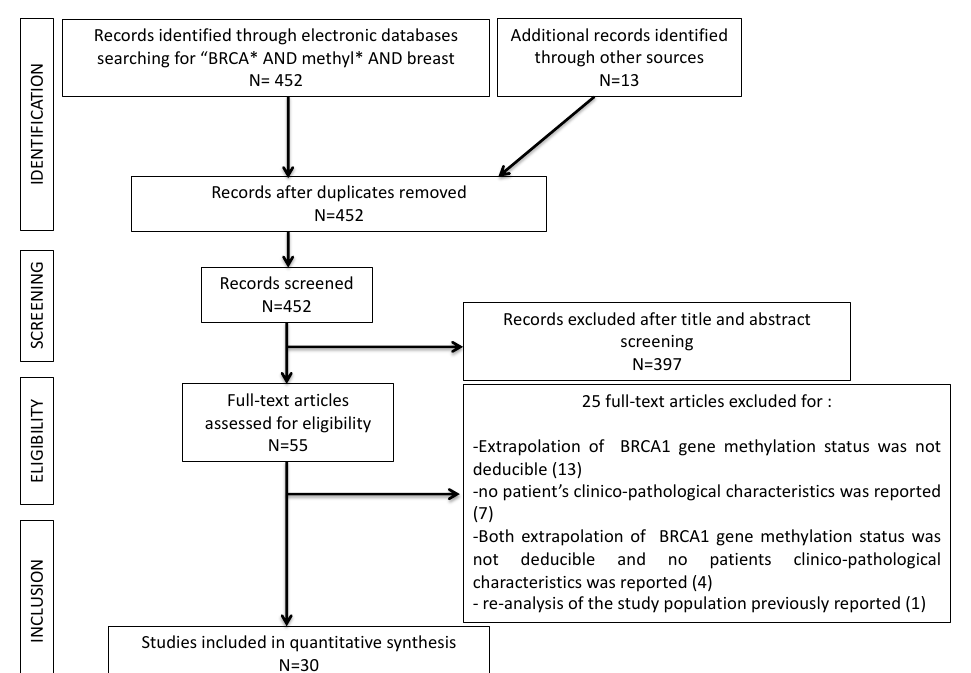
Figure 1. PRISMA flow-chart of the study selection process. Table 1. Characteristics of the included studies.